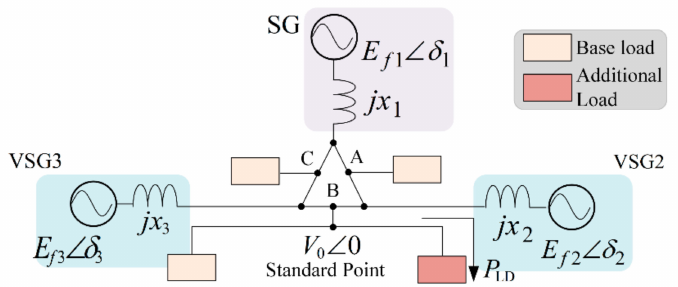
Figure 3. Connection diagrams of the Institution of Electrical and Electronic Engineering (IEEE) 9 bus system.